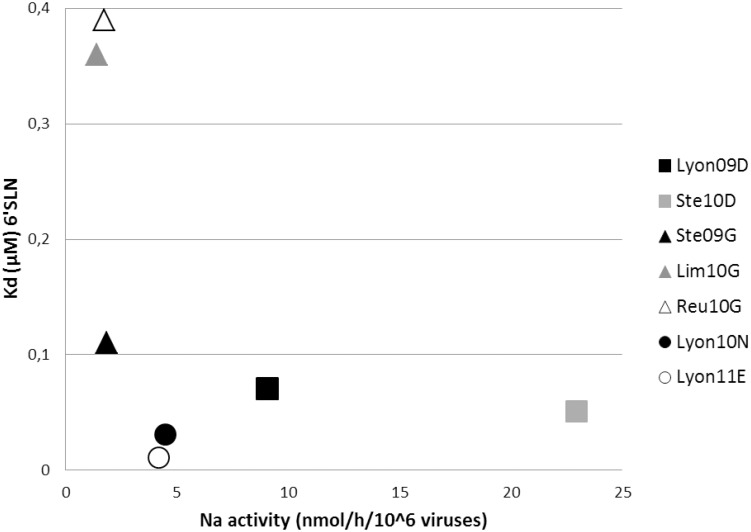
Functional HA-NA balance of H1N1pdm HA 222 variants.The relationship between the activity of HA and NA was assessed by plotting the quantitative results from the HA binding affinity assay with the NA activity.